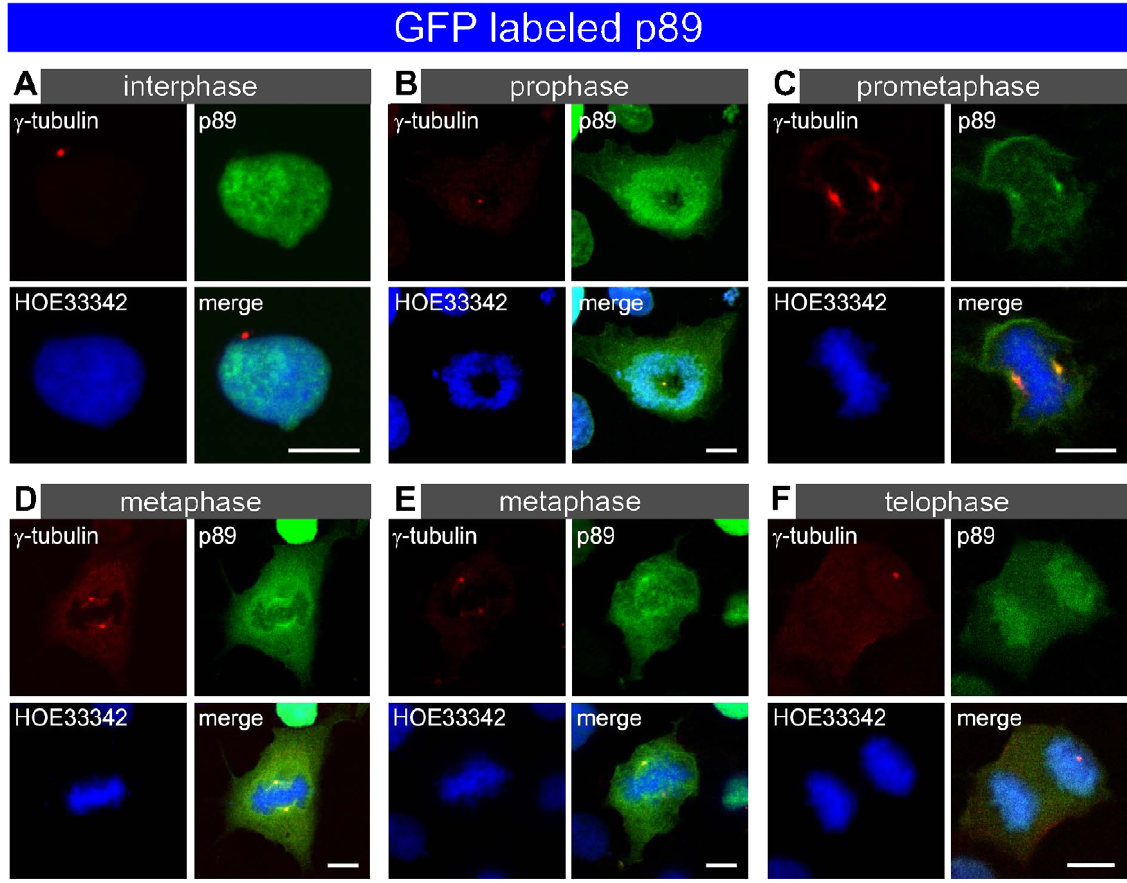
Fig. 2. GFP-p89 also localizes to the centrosome during mitosis. (A–F) GFP-p89 shows the same distribution during the cell cycle as endogenous p89. In interphase (A) GFP-p89 nearly exclusively localizes in the nucleus with no signal at the interphase centrosome. Starting from prophase (B), signals can be detected at the centrosomes. Starting from prometaphase throughout metaphase, staining of centrosomes is intense, whereas no chromosomal localization is found (C–E). In late telophase (F), intensity at the centrosomes decreases, and chromosomal association increases again. Scale bars = 10 µm. Red – γ -tubulin, green – GFP-p89; blue –